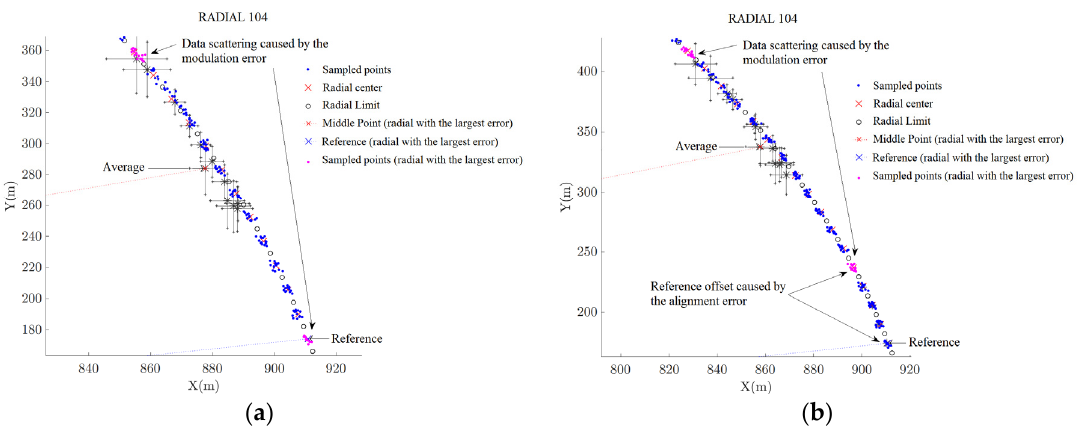
Figure 12. VOR inspection using the developed HIL platform: ( a ) Test 4 ; ( b ) Test 5 . Table 10. The results given by the develop HIL platform.